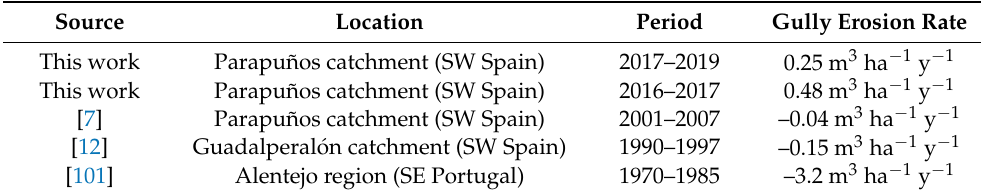
Table 7. Gully erosion rates in Parapuños and other agrosilvopastoral